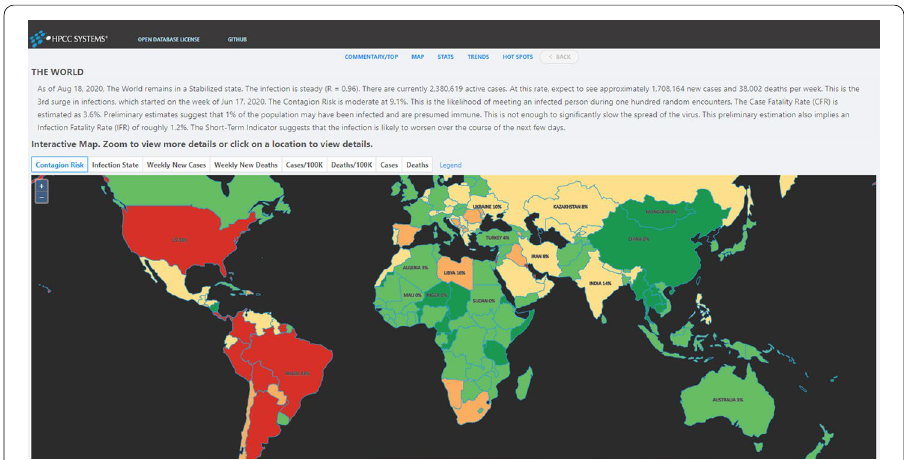
Fig. 9 World Map View: shows aspects of the infection through color coding on a map. The map can be color-coded by a number of attributes including Infection State, New Cases, New Deaths, Cases per 100 K, Deaths per 100 K, Total Cases and Total